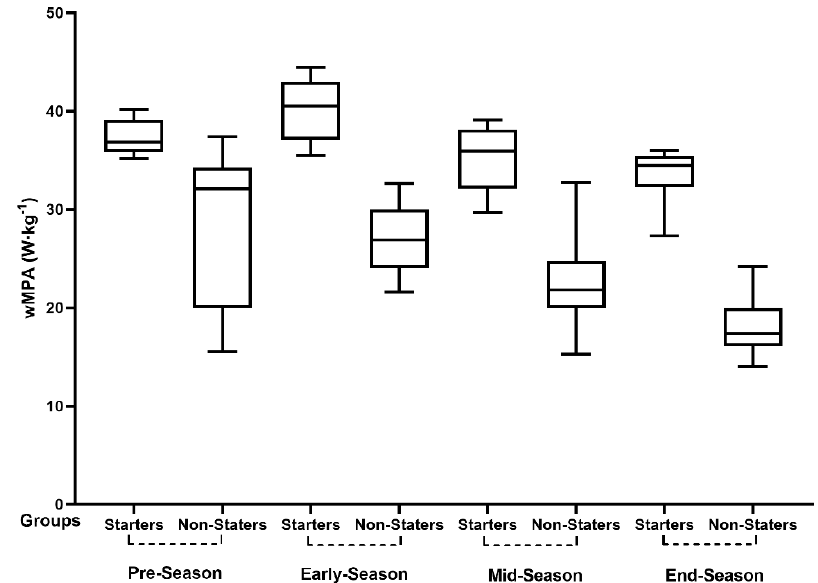
Figure 1. Pairwise comparisons between season periods in wMPA. WMPA, weekly metabolic power average; W·kg − 1 , watts per kilogram.